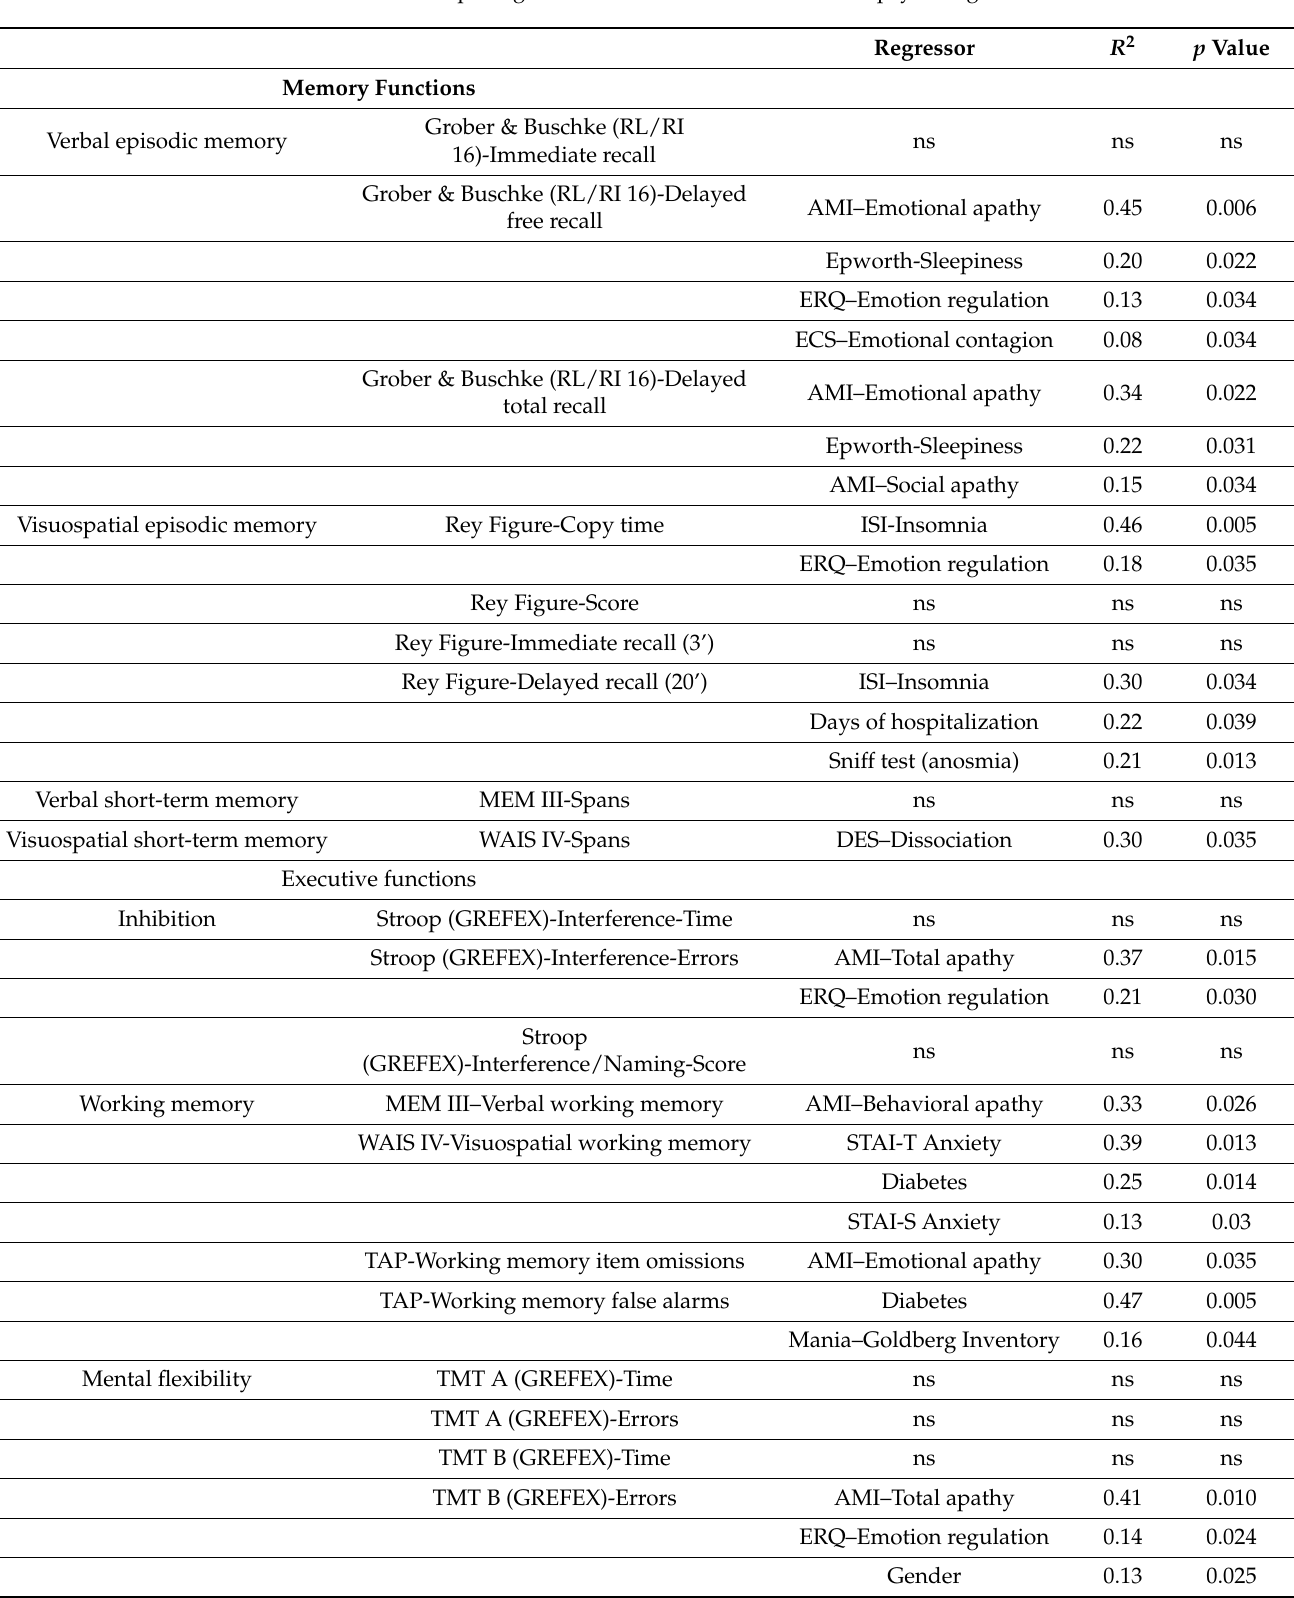
Table 5. Multiple regression results for each of the neuropsychological